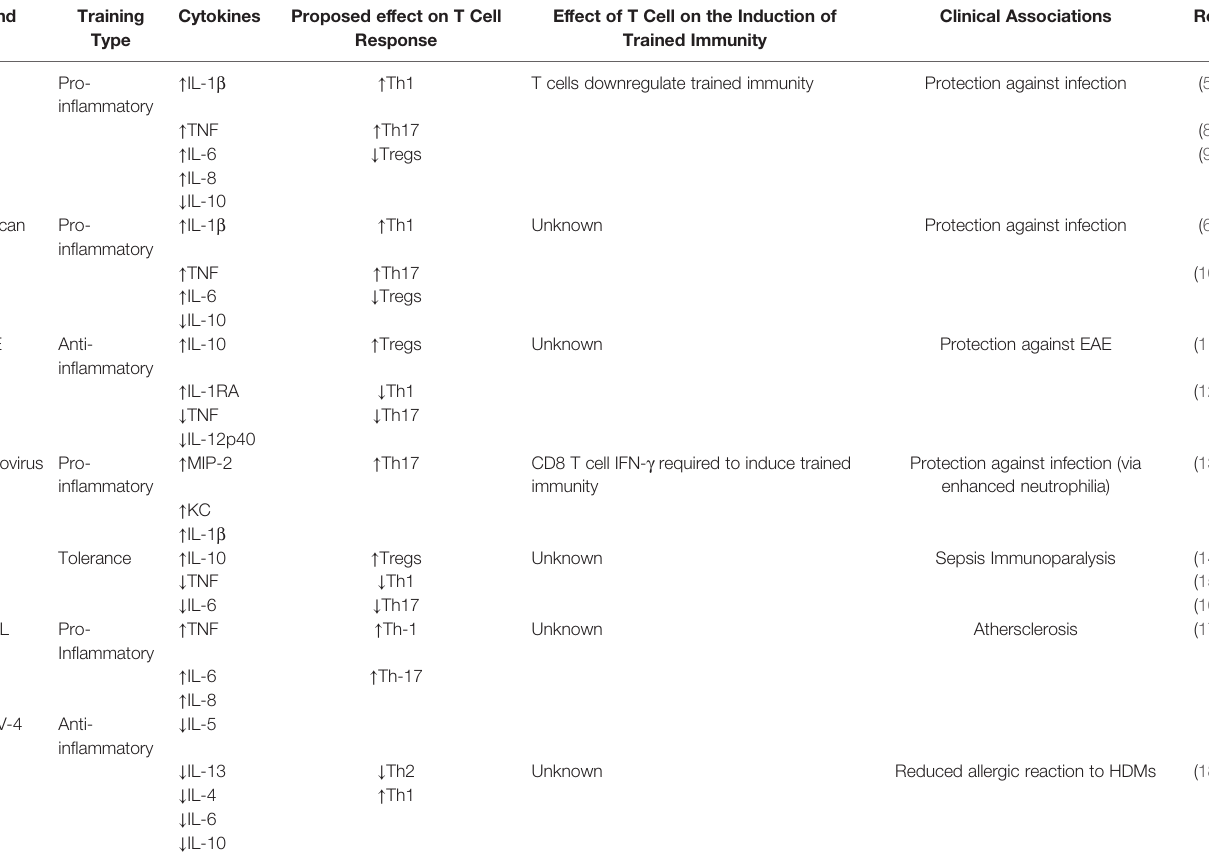
TABLE 1 | Summary of the type of trained immunity induced by different stimuli, their proposed effect on the T cell response and clinical associations.